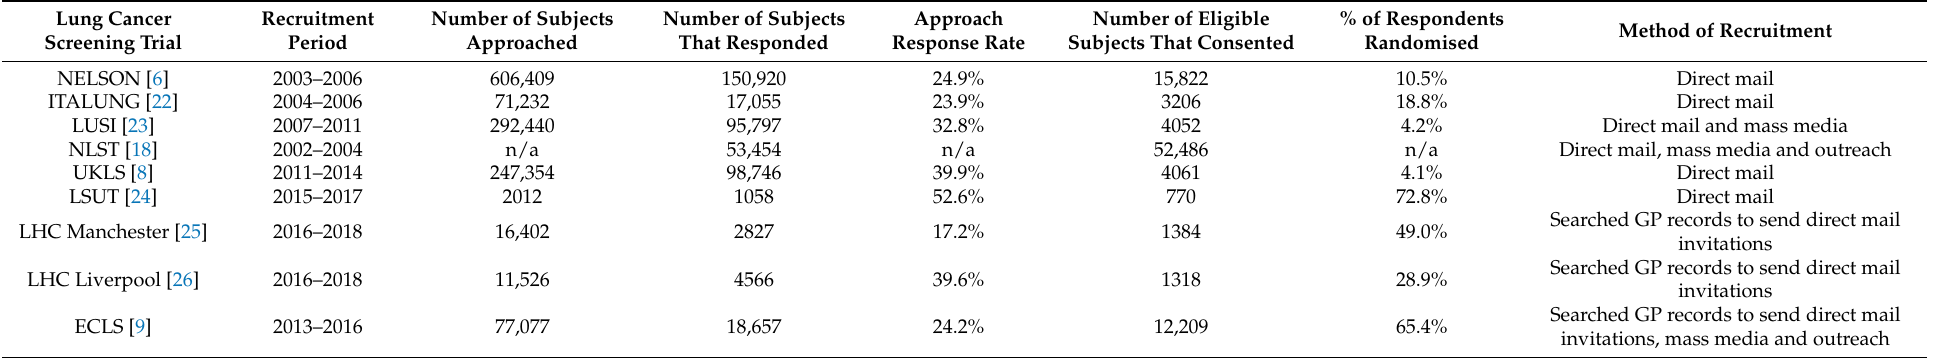
Table 1. The recruitment strategies, numbers of subjects approached, numbers of respondents and the percentage of respondents randomised in major European lung cancer screening trials. Lung Cancer Screening